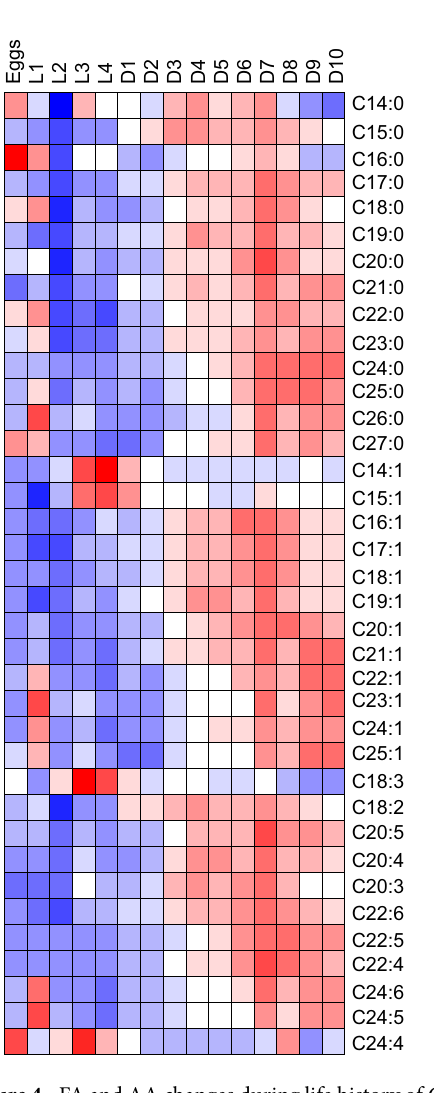
Figure 4. FA and AA changes during life history of C. elegans . ( a ) FAs were measured in the different life history stages of C. elegans , i.e. eggs, four larval stages, and the first 10 days of adulthood. The abundance of FAs was low during the larval stages, increased during the reproductive phase (day 2–5) and decreased post- reproduction after reaching a peak at day 7 of adulthood. C18:3 reached the highest abundance during the later developmental phase and decreased with age. ( b ) Most AAs reached a peak during the later larval stages and decreased in the adult phase. The abundance of aspartic acid and glycine remained low in development and early adulthood, and significantly increased at later ages. See also Supplementary Fig.